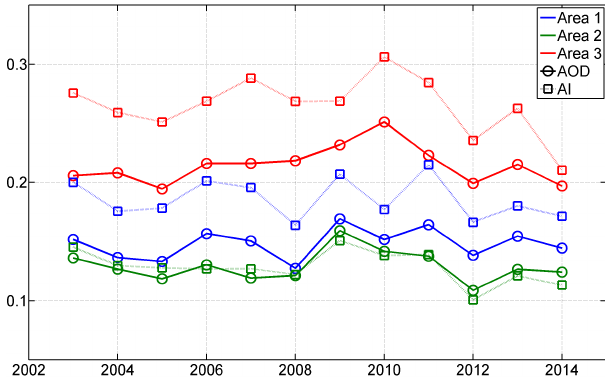
Figure 2. Time series of summer (JJA) averages for AOD (circles) and AI (squares) for the three subregions. The three subregions are colour-coded as in Fig.